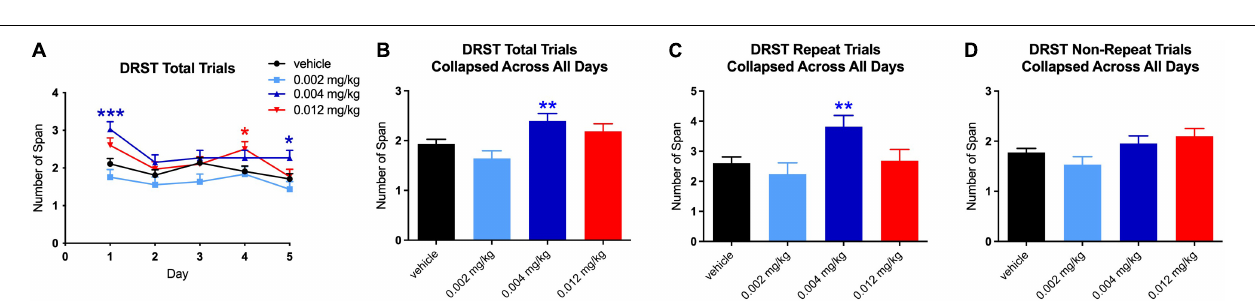
FIGURE 3 | Effect of PF-6294 on DRST Spatial Overall Performance. (A) Analysis revealed across all days for total trials of the DRST a significantly higher span for the middle dose on day 1 (*** p = 0.0002) and on day 5 (* p = 0.035). The total span was also higher on day 4 for the highest dose (red * p = 0.025). (B) Overall, when collapsed by day, there was a significantly higher total span achieved at the middle dose (** p = 0.003). (C,D) Graphs show that the increase was due to the effect on repeated trials ( p = 0.004), but not non-repeated trials. Error bars =